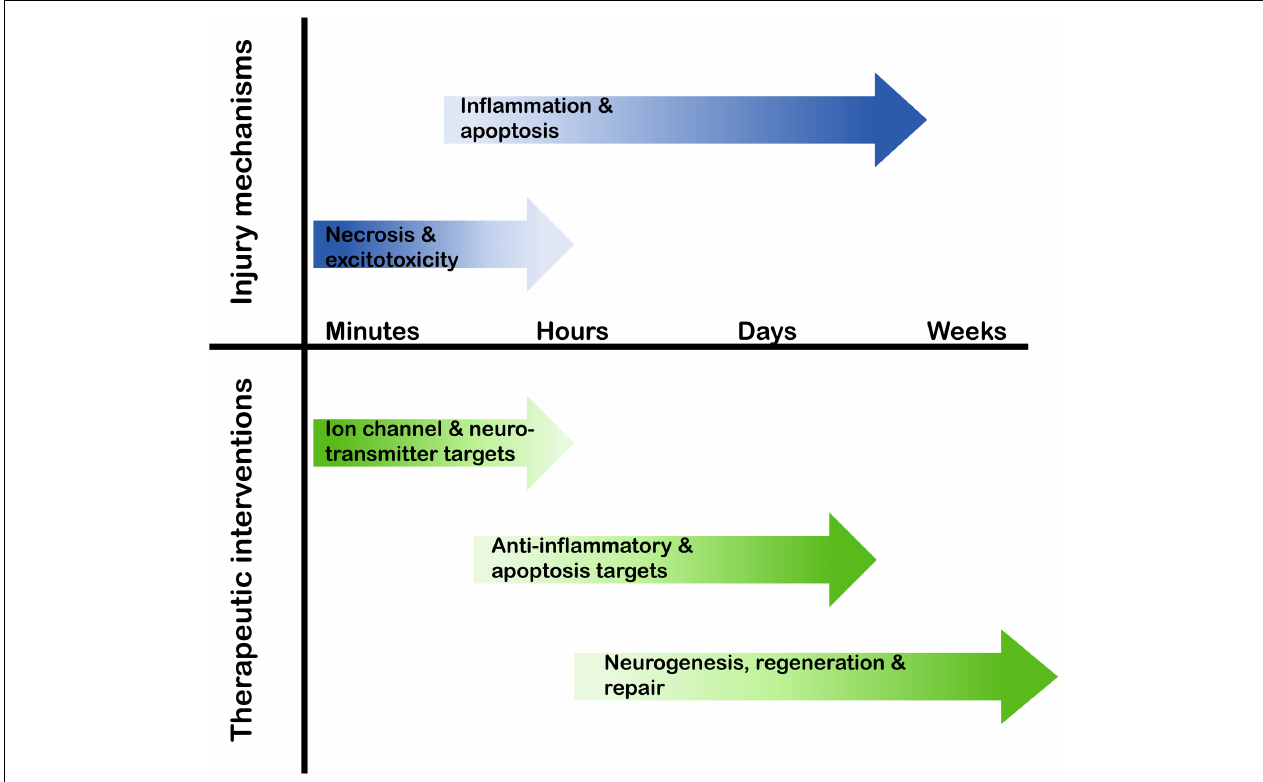
FIGURE 1 | Therapeutic target timeline following a stroke. In the minutes to weeks following a stroke the cellular and molecular pathways that are activated alter, therefore the potential therapeutic targets and possible interventional approaches need to align with this temporal profile.